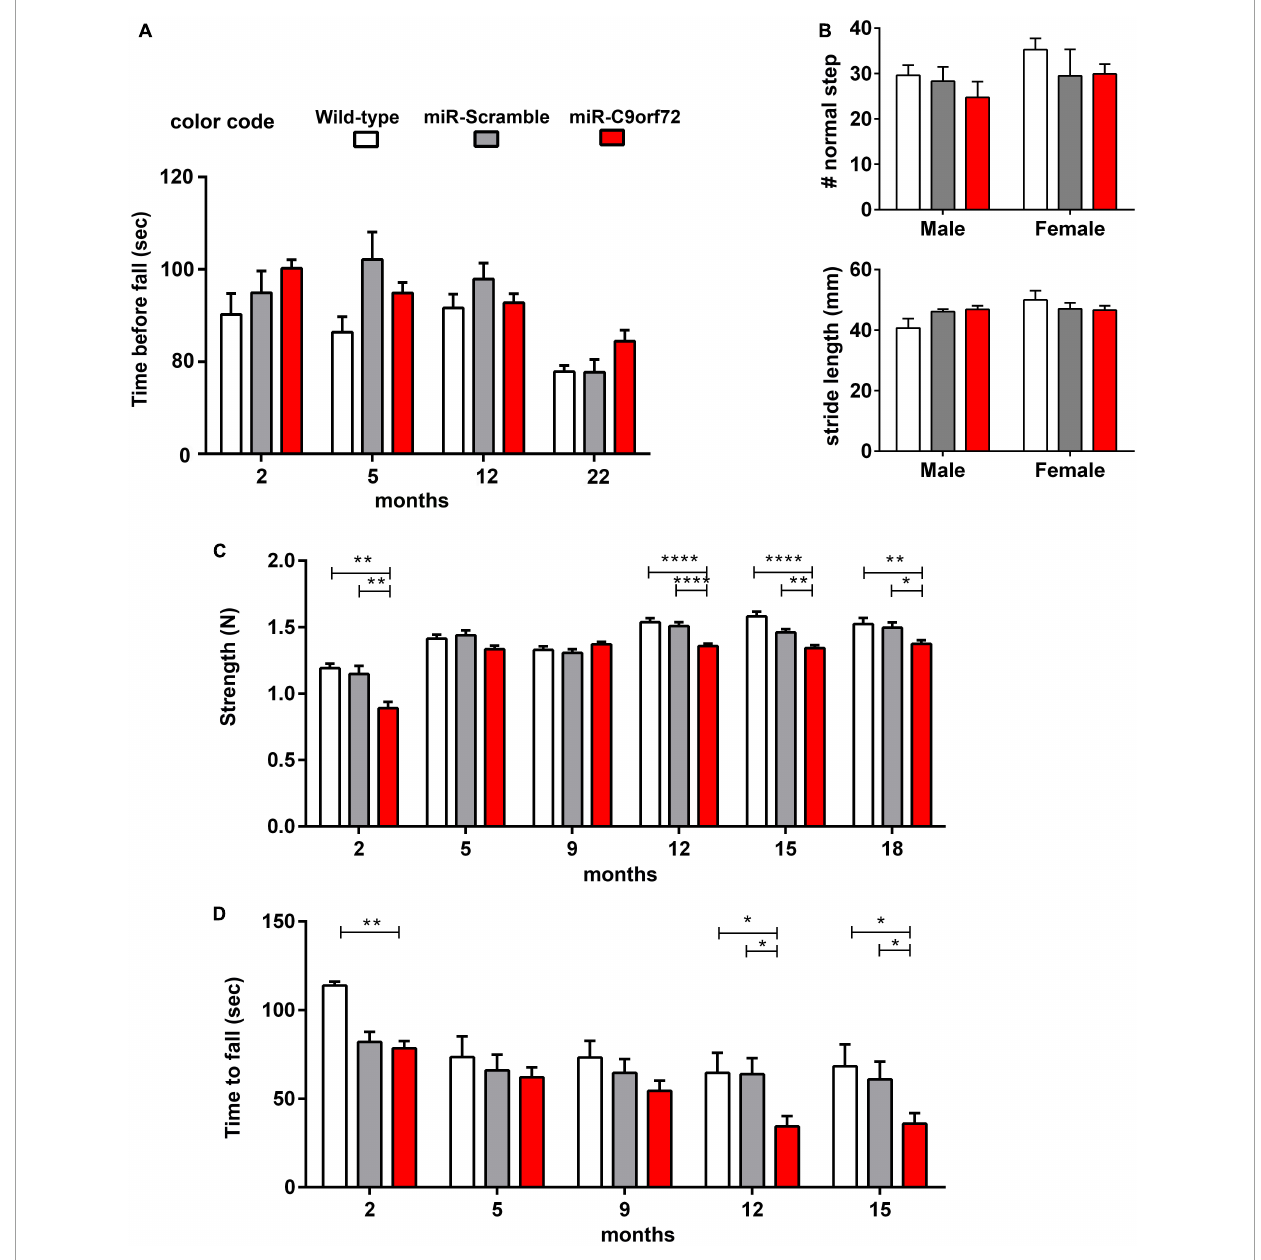
FIGURE5 Age-dependent strength loss but absence of motor deficits in C9ORF72 deficient mice. (A) Rotarod testing of C9ORF72 deficient mice at 2, 5, 9, 12, and 22 months (wild-type n = 10; miR-Scramble n = 12, miR-C9orf72 n = 34). No differences of sensorimotor coordination, or motor learning were observed across trials in young or aged animals. (B) Quantification of normal step number and stride length by Treadmill. No alteration could be seen with C9ORF72 deficient animals (wild-type n = 10; miR-Scramble n = 12, miR-C9orf72 n = 34). (C) Hind limb grip strength measured at 2, 5, 9, 12, 15, and 22 months (wild-type n = 10; miR-Scramble n = 12, miR-C9orf72 n = 34). (D) Hanging wire test measuring time to fall at 2, 5, 9, 12, and 15 months (wild-type n = 10; miR-Scramble n = 12, miR-C9orf72 n = 34). Error bars represent SEM; *p < 0.05, **p < 0.01, ****p <